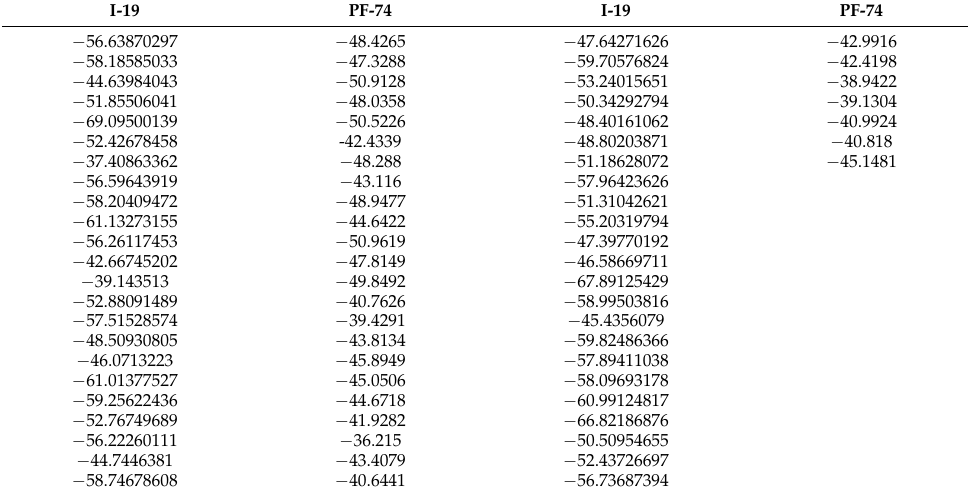
Table 3. Thermal-binding energy calculated (after ligand stability) for every 2 ns during trajectory.